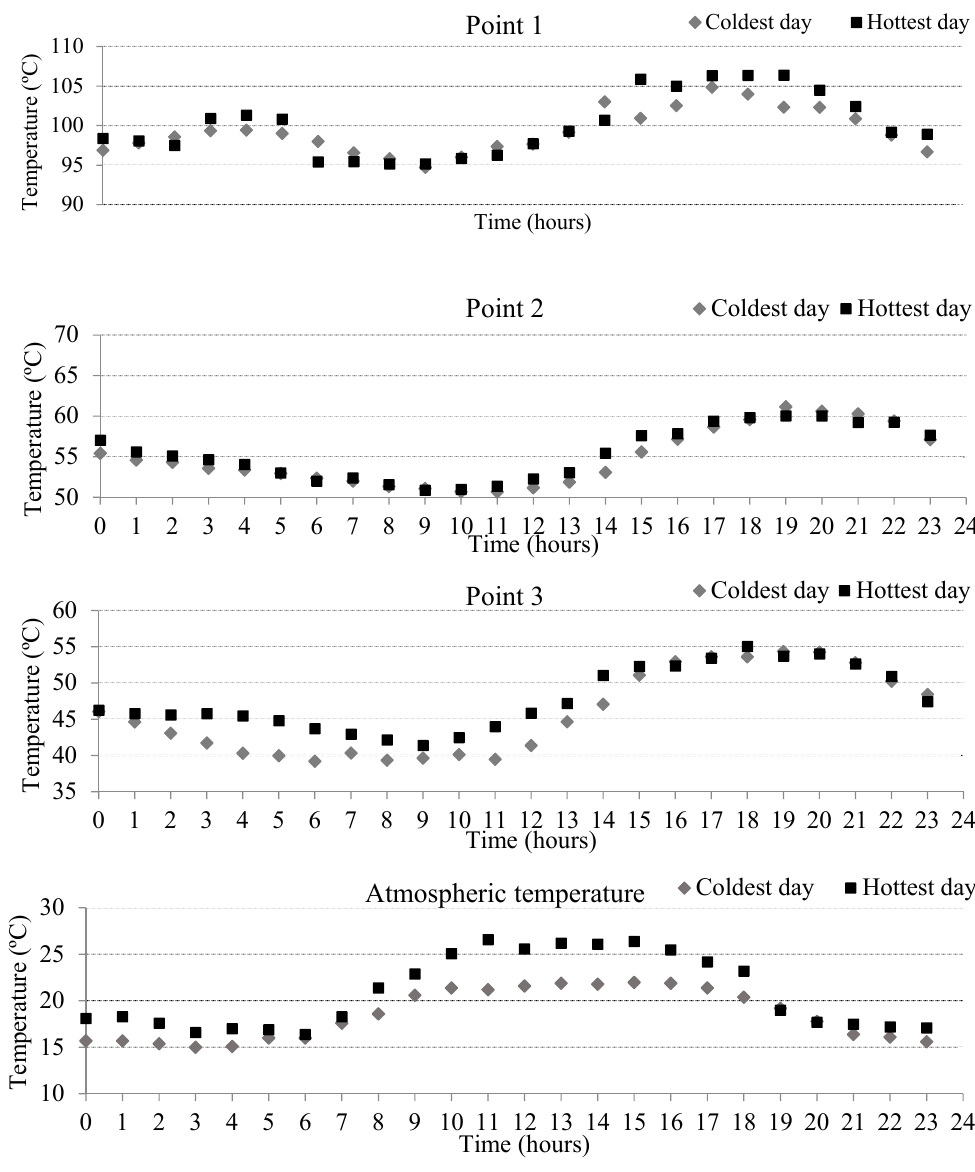
Figure 11. Graphical representations of temperatures at points 1, 2, 3 and atmospheric temperature on the coldest and hottest days.